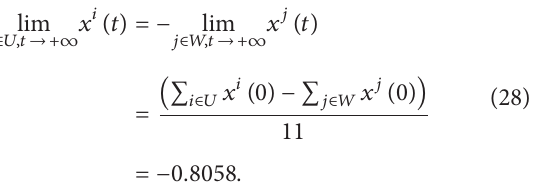
Figure 2: Herschel graph: bipartite style.